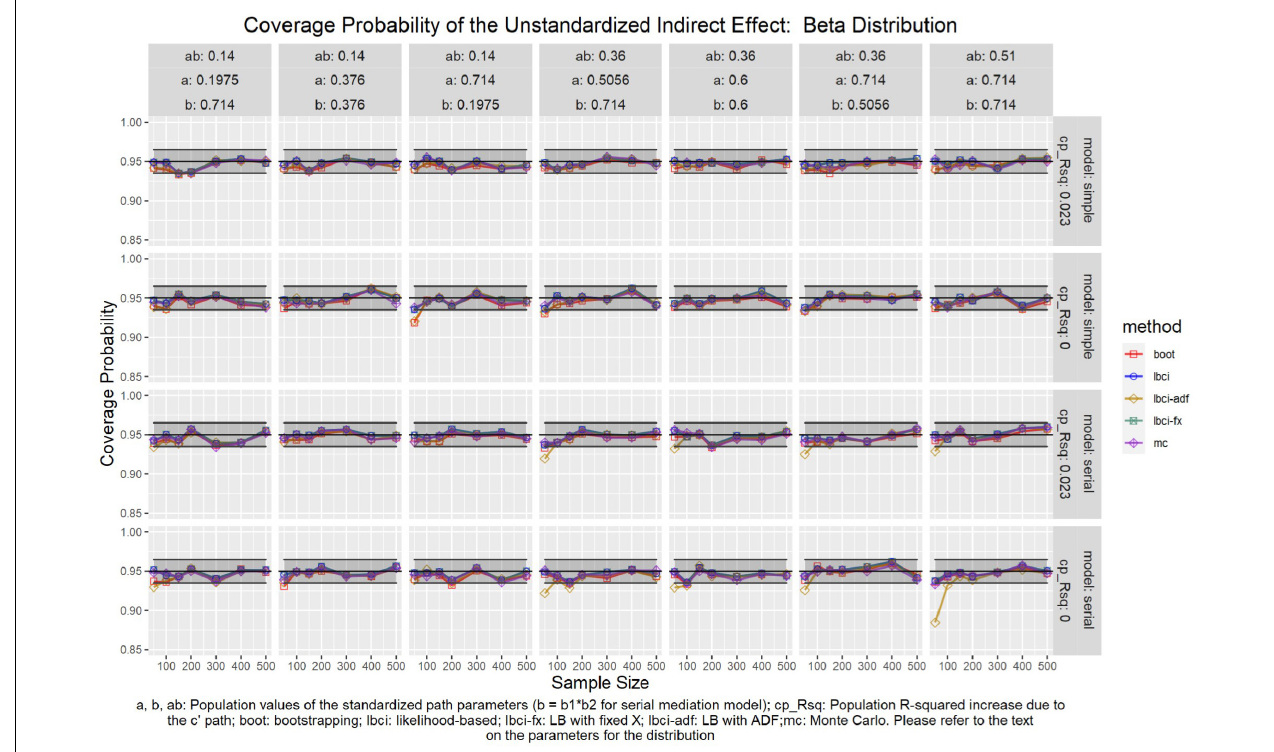
FIGURE 6 | Beta Distribution (Unstandardized Indirect Effect). a, b, ab: Population values of the standardized path parameters (b = b1 × b2 for serial mediation model); cp_Rsq: Population R-squared increase due to the c (cid:48) path; boot: bootstrapping; Ibci: likelihood-based; Ibci-fx: LB with fixed X; Ibci-adf: LB with ADF;mc: Monte Carlo. Please refer to the text on the parameters for the